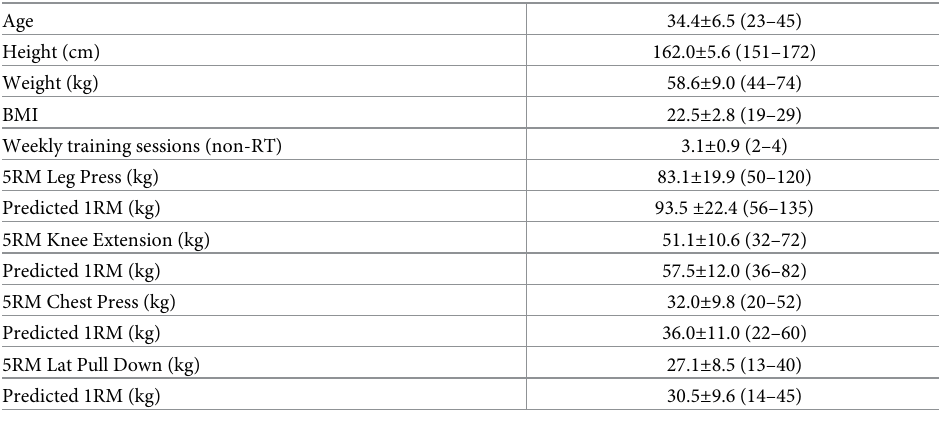
Table 1. General